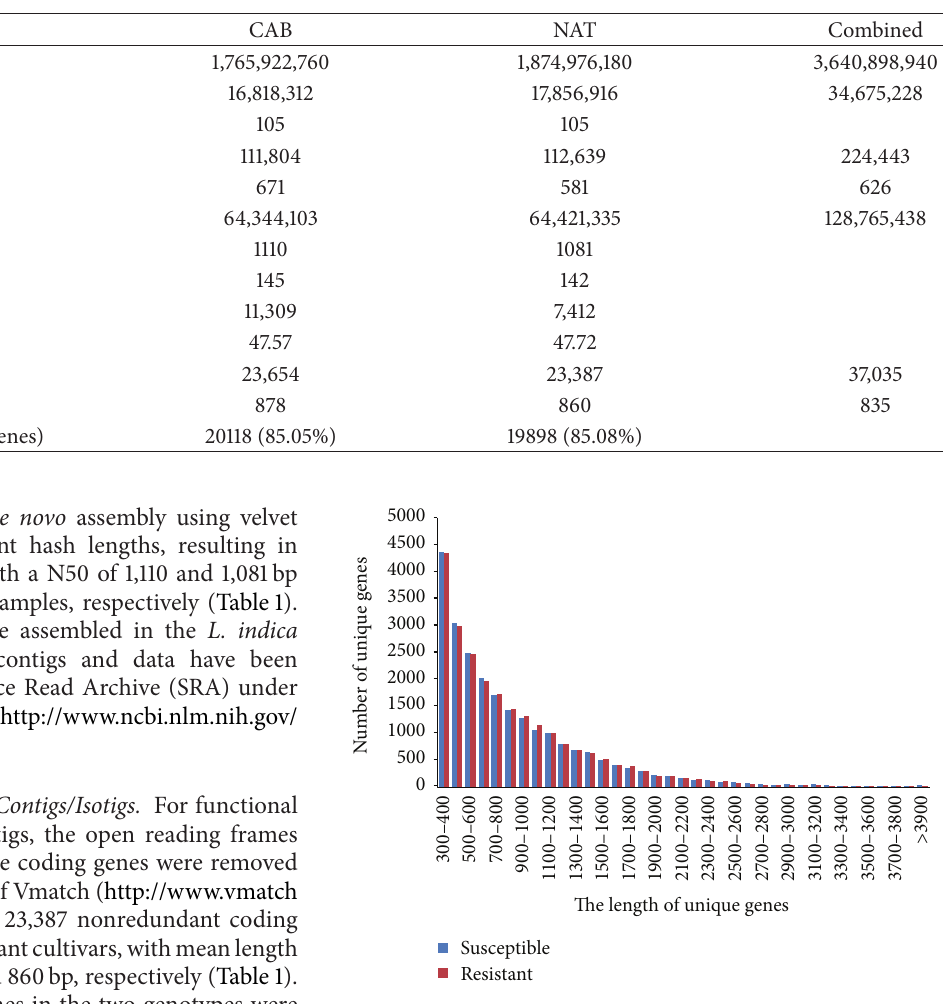
Table 1: Summary of sequencing data of two Lagerstroemia indica cultivars: powdery mildew susceptible (“Carolina Beauty,” CAB) and powdery mildew resistant (“Natchez,” NAT), resulting from Illumina deep sequencing.